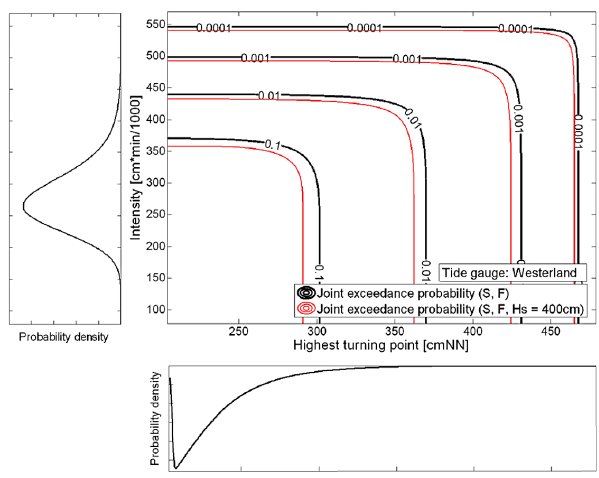
Fig. 11. Comparison of the results from bivariate statistical analyses for the parameters S and F and trivariate analyses for the parameters S , F and H s (with H s =